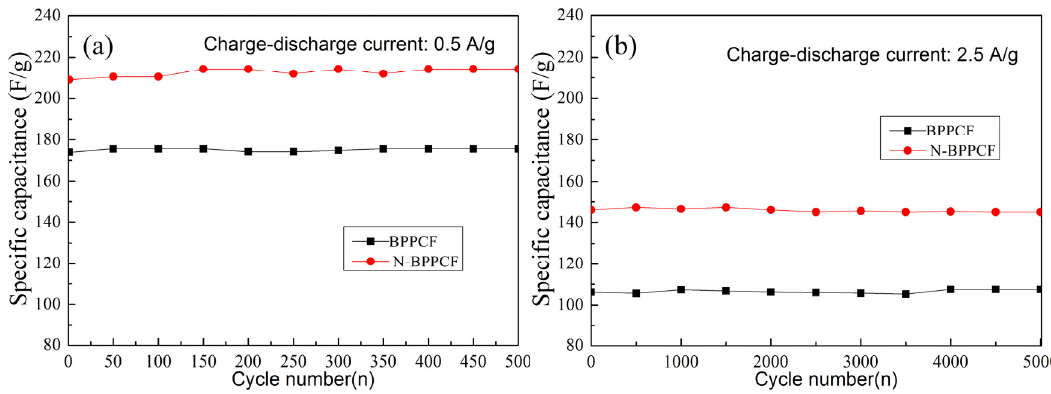
Figure 7. Cycle life of BPPCF and N-BPPCF at various currents: ( a ) 0.5 A/g for 500 cycles and ( b ) 2.5 A/g for 5000 cycles.